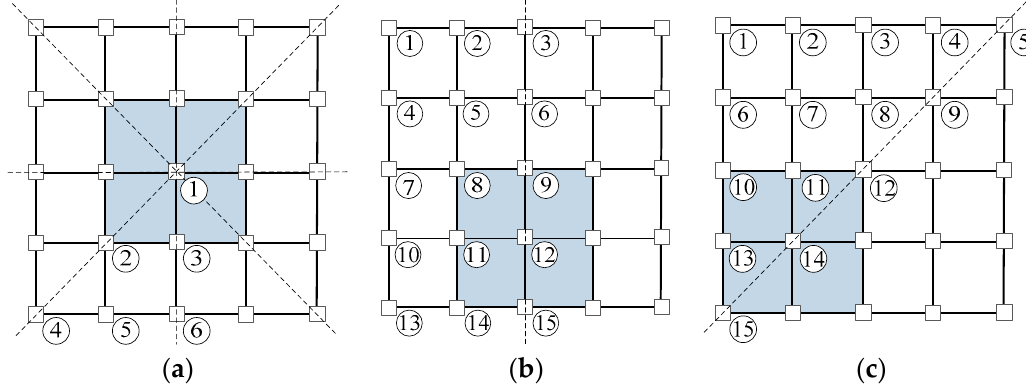
Figure 2. Structure plane layout and distribution of cases. ( a ) Model A; ( b ) Model B; ( c ) Model C.